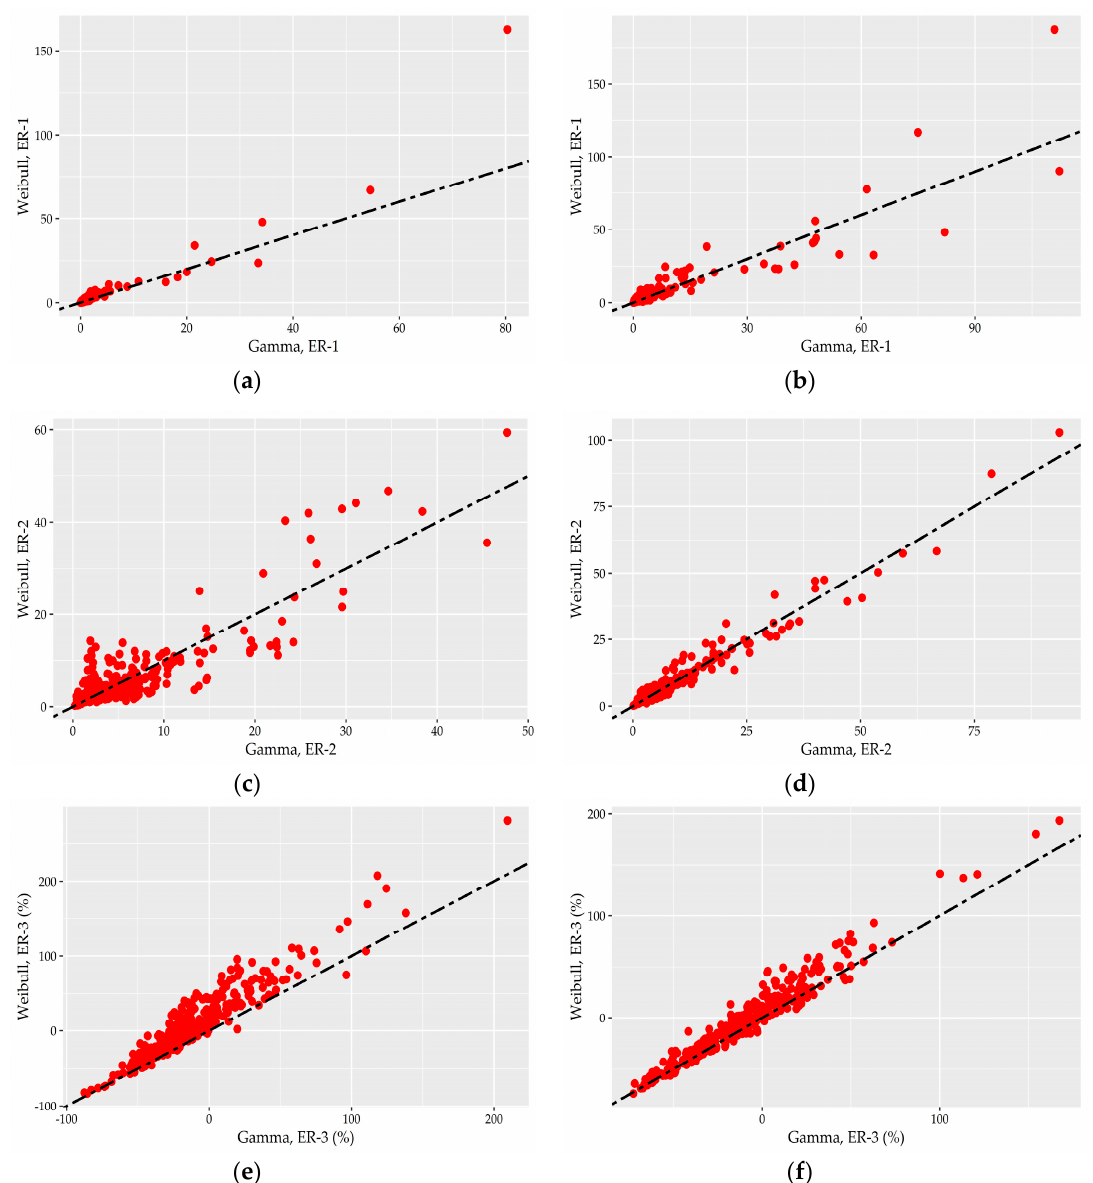
Figure 9. Scatter plots that compare the fitting performance of the Gamma and Weibull distributions for the individual records at 15-minute ( left column , a , c , e ) and hourly ( right column , b , d , f ) scale. Red points represent the values of the goodness-of-fit measures of individual series.